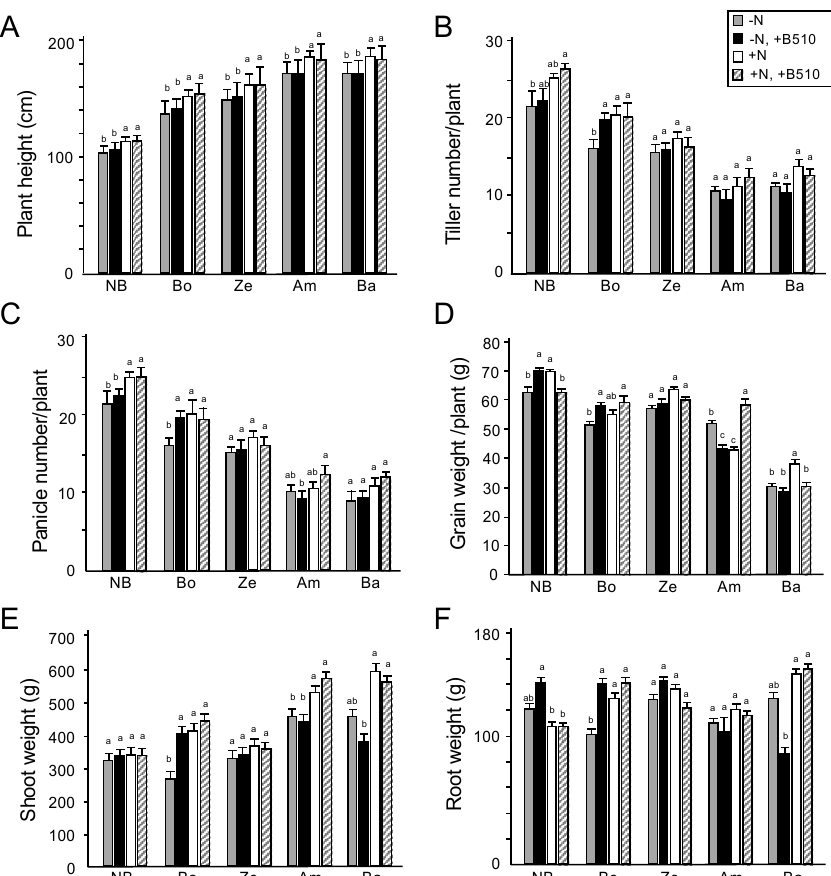
Figure 2. The effect of Azospirillum on plant growth under -N and +N conditions at 90 days after transplantation (harvesting stage). The plant growth characteristic assessed were plant height ( A ), tiller number ( B ), panicle number ( C ), grain weight ( D ), shoot weight ( E ) and root weight ( F ). The different rice cultivars used in this analysis were Nipponbare (NB), Ex-Boako (Bo), Zebila (Ze), Ex-Amantin (Am), and Bawku-Market (Ba). Statistical analysis was performed, the different letters (a, b, c) indicate the significant differences between treatments (Student–Newman–Keuls (SNK) test, p < 0.05, n =